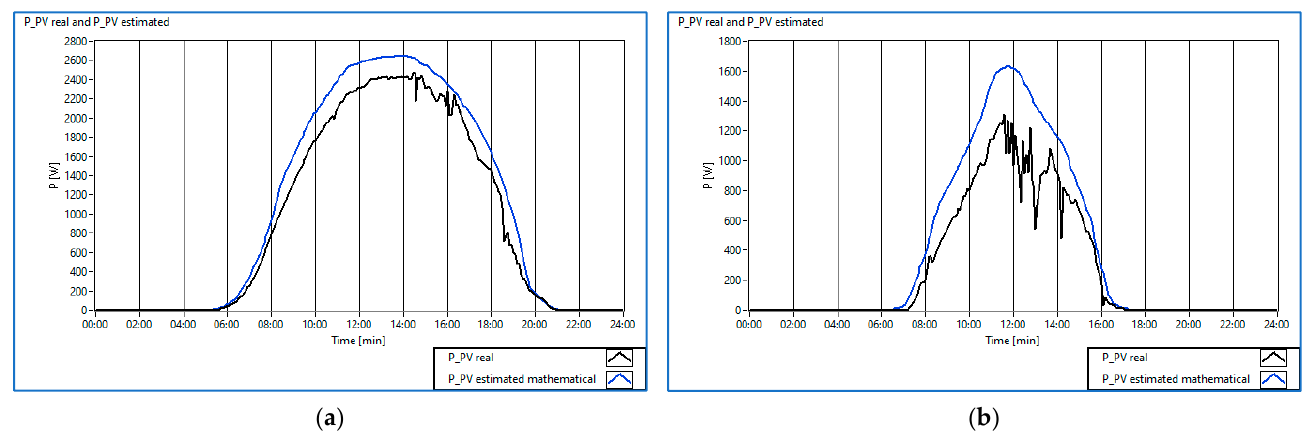
Figure 6. P PV real and P PV estimated with mathematical model for: ( a ) scenario 1; ( b ) scenario 2.